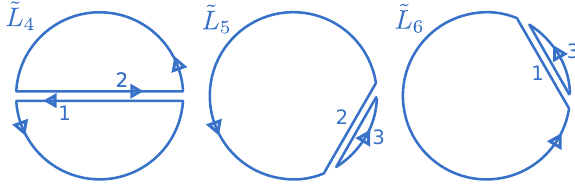
Figure 38 . The three lifts of the unknot L involving